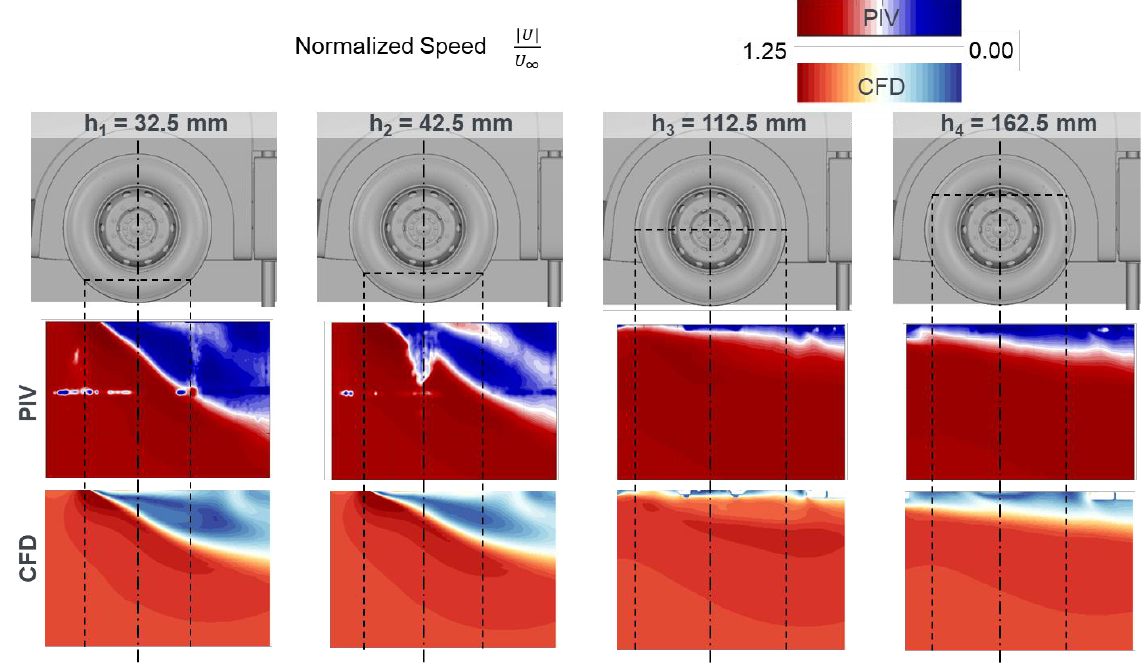
Figure 8. Flow field comparison: PIV measurements and CFD results on several 340 mm × 150 mm planes for the front wheel with longitudinal grooves and standard rim.